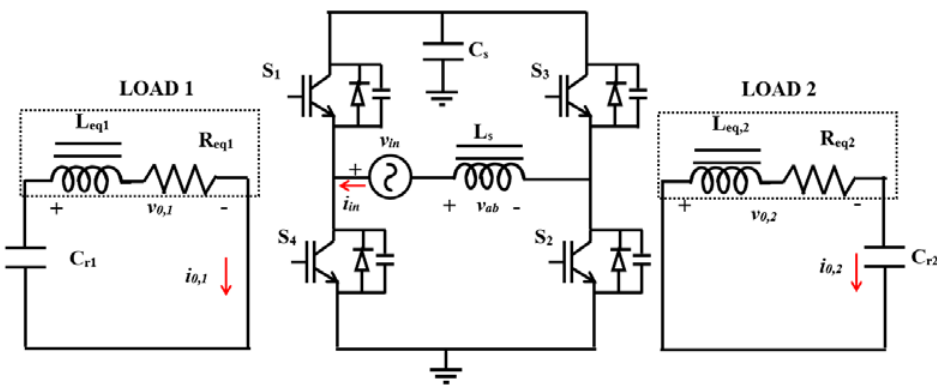
Figure 1. Circuit diagram of single-stage AC-AC converter.